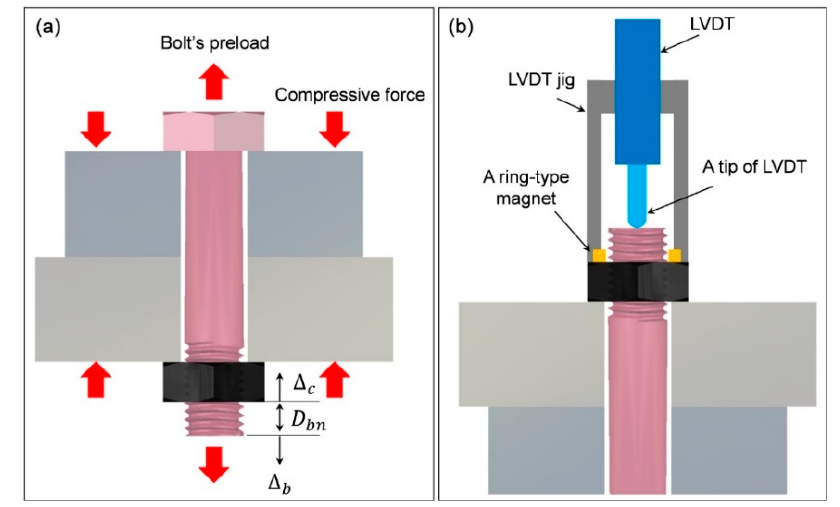
Figure 1. Schematic diagrams of ( a ) the common bolted joint and ( b ) the concept of L-PMS.